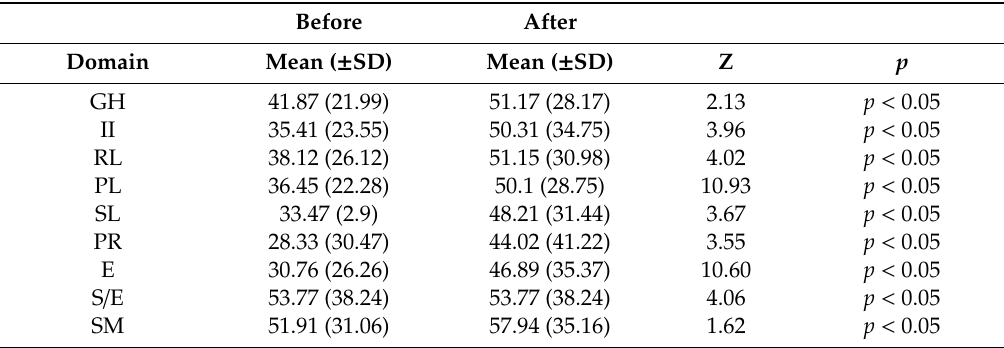
Table 7. King’s Health Questionnaire (KHQ) results in the study group before surgery and after 6 months follow-up (Wilcoxon’s signed-rank test).